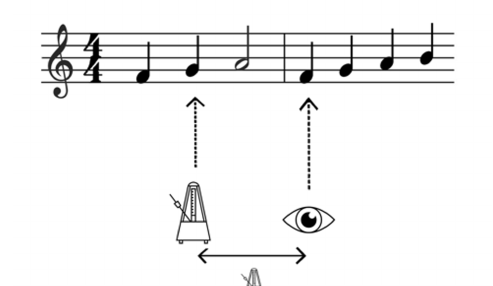
Figure 5. Representation of EHS measured in musical